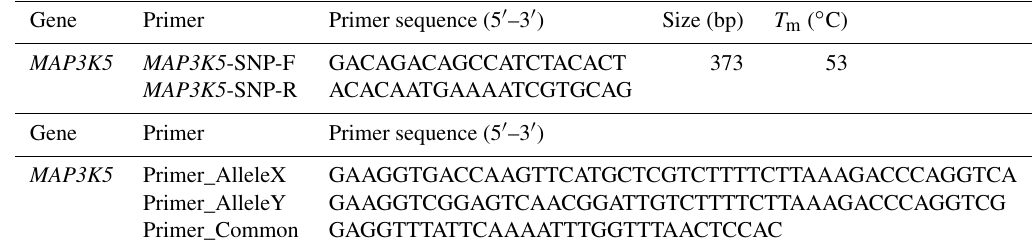
Table 1. Primer sequences and PCR conditions and primers used to the KASPar technology. Gene Primer Primer sequence (5 (cid:48) –3 (cid:48) ) Size (bp) MAP3K5 MAP3K5 -SNP-F GACAGACAGCCATCTACACT MAP3K5 -SNP-R ACACAATGAAAATCGTGCAG Gene Primer Primer sequence (5 (cid:48) –3 (cid:48) ) MAP3K5